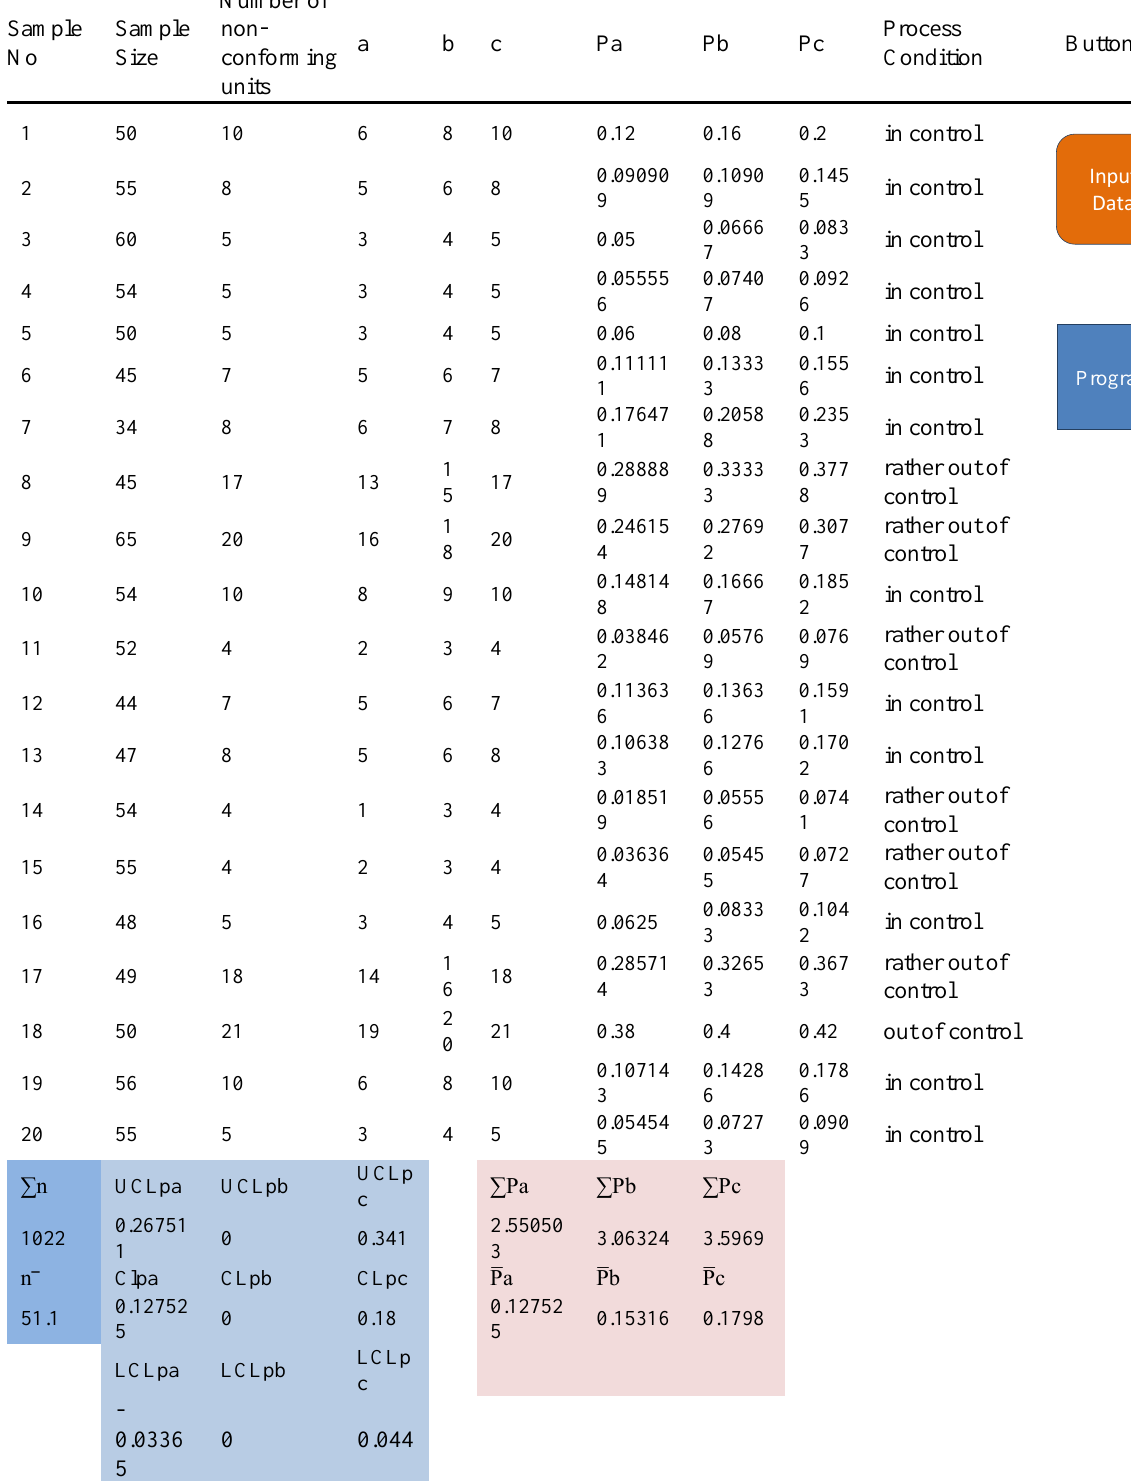
Table 4. Marcucci Approch for Variable Sample Size